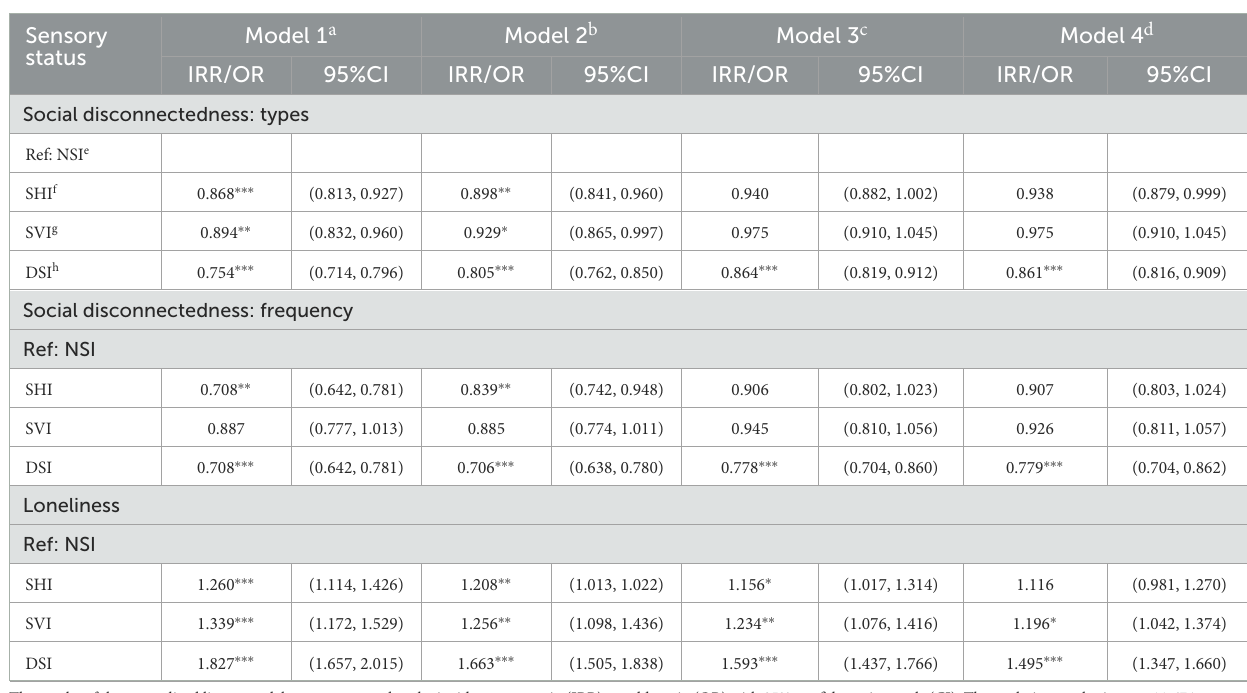
TABLE 3 Cross-sectional generalized linear analysis of sensory impairments and social